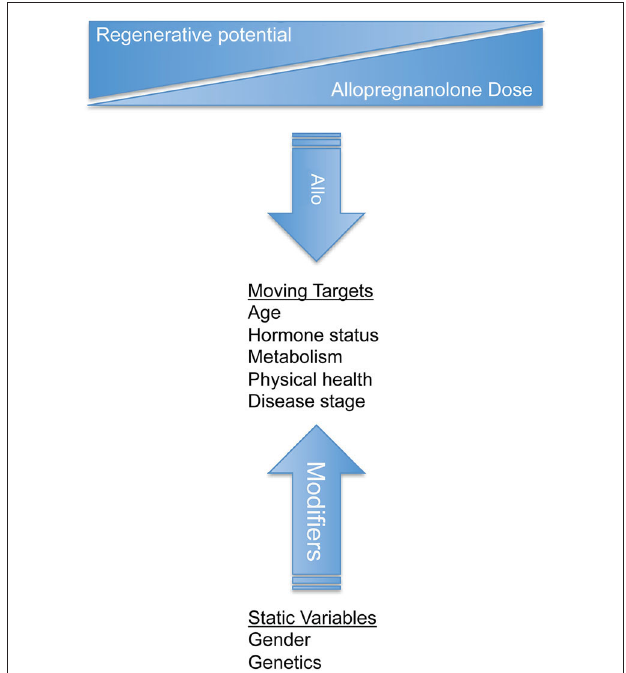
FIGURE 4 | Design of clinical trials for allopregnanolone should consider both static variables and moving targets to treat neurological disorders. Gender and genetics are static variables that influence disease and response to treatment. Static variables impact the moving targets such as age, hormone status, metabolism, health, and disease progression. Successful clinical therapeutic strategies should be tailored for each disease state and should be monitored as the disease and treatment progresses. Dynamic biological processes require an understanding of disease system pathogenesis to select and modify the appropriate treatment